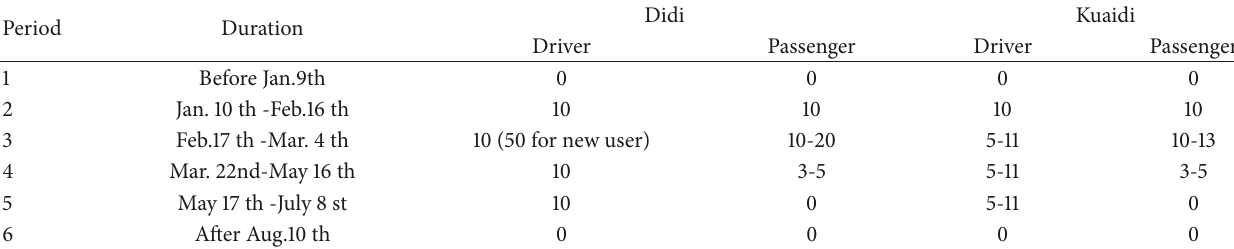
Table 1: Subsidy policies in different periods during the subsidy war (Unit: RMB